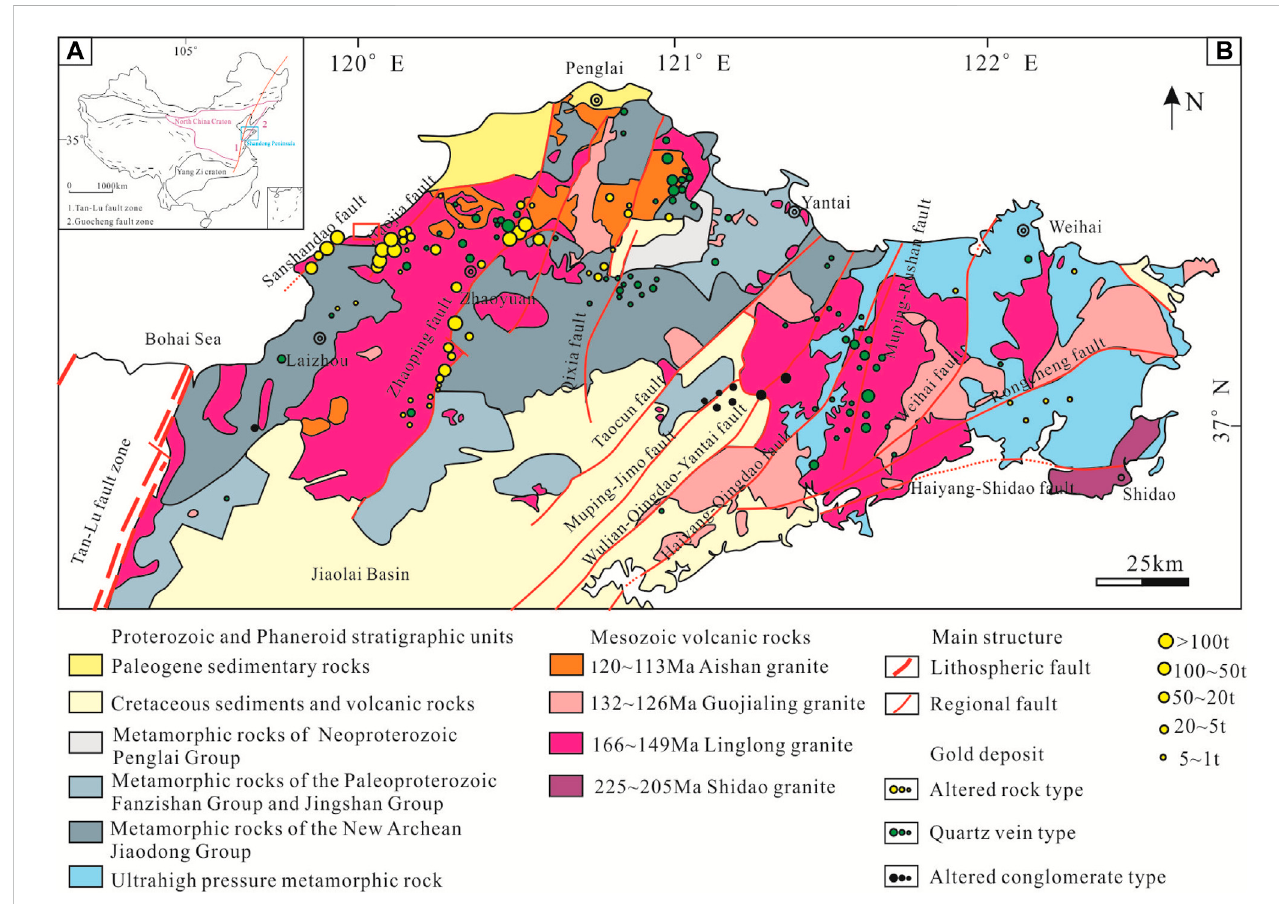
FIGURE 1 Types and spatial distribution of key ore deposits in the Jiaodong gold province (modi fi ed after Yang et al., 2017).